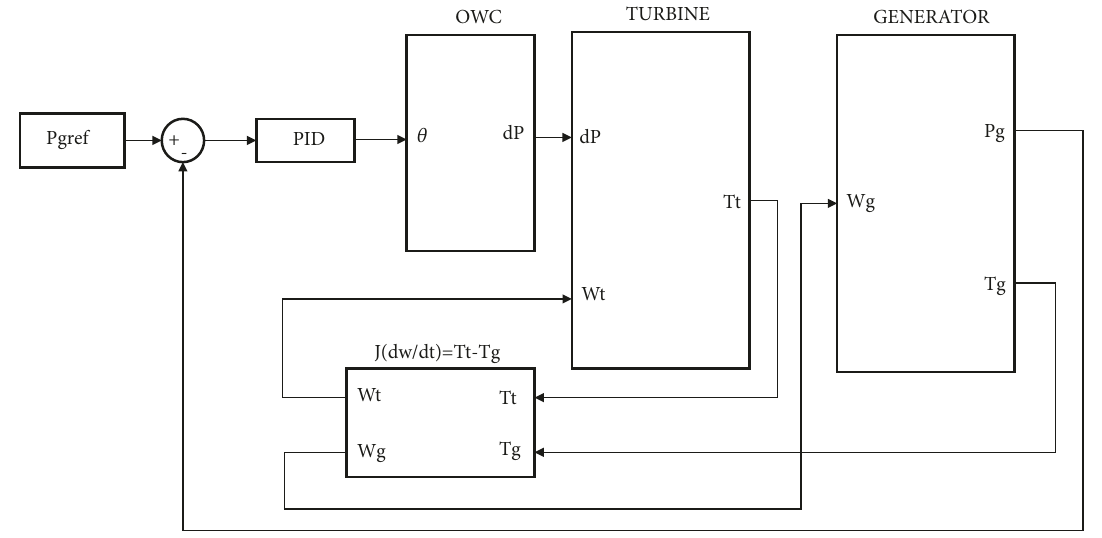
Figure 2: Rotational speed control diagram.